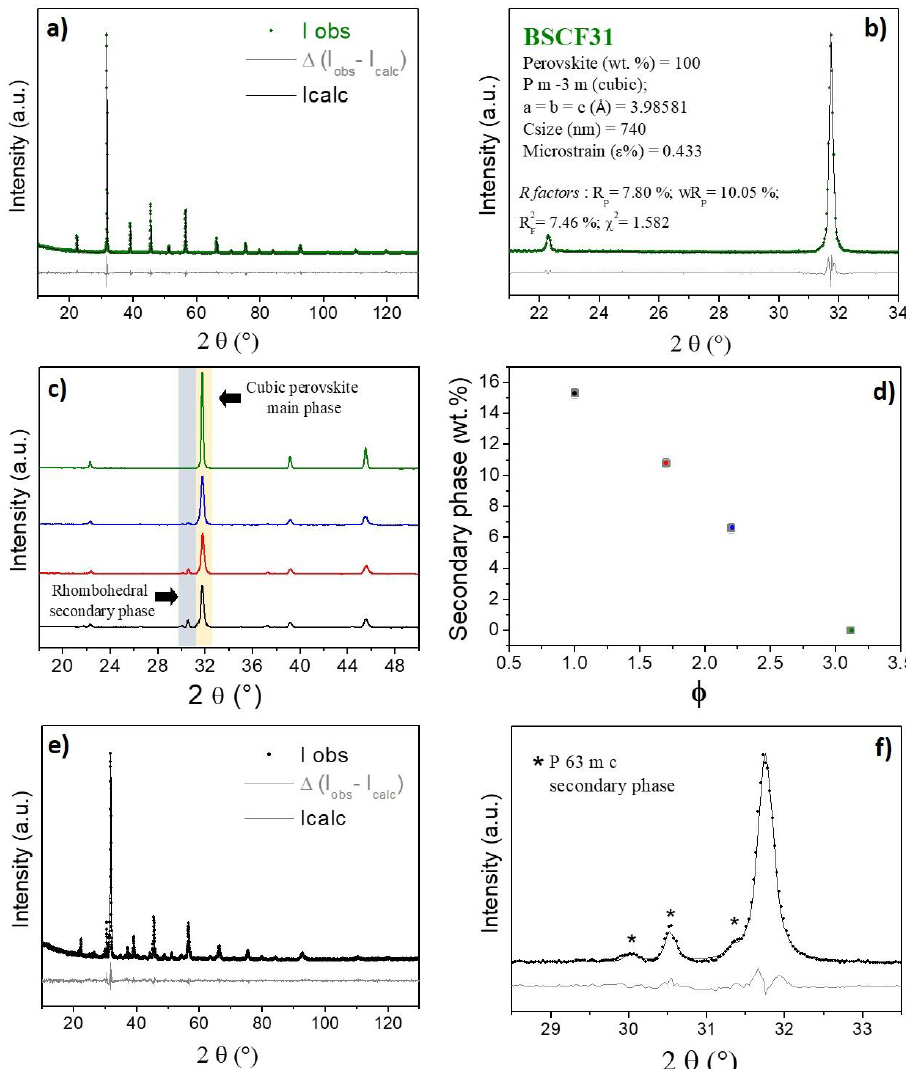
Figure 2. ( a ) Rietveld refinement of the XRD pattern of BSCF31 after calcination at 950 ◦ C for 5 h: XRD experimental data (green full circles), fitted data (black line) and residual (grey line); ( b ) inset showing the 21–34 ◦ 2 θ region, reliability factors and other structural parameters obtained from Rietveld analysis; ( c ) insets of the XRD patterns of BSCF10 (black), BSCF17 (red), BSCF22 (blue) and BSCF31 (green) thermally treated at 950 ◦ C / 5 h. Rectangles evidence the main peak of the perovskite (light orange) and secondary phase (dark grey); ( d ) linear trend of the secondary phase amount (wt. %) with the reducers-to-oxidizers ratio; error bars are also indicated in the graph for each secondary phase percentage; ( e ) Rietveld refinement for BSCF10 treated at 950 ◦ C: XRD data (black dots), model (black line) and residual (grey line); in the inset ( f ), the P 63 m c secondary phase is evidenced by asterisks and its refined cell parameters are a = b = 11.7063 ± 0.0008 Å, c = 6.9092 ± 0.0007 Å and α = β = 90 ◦ γ = 120 ◦ , V = 820.0 ± 0.1Å 3